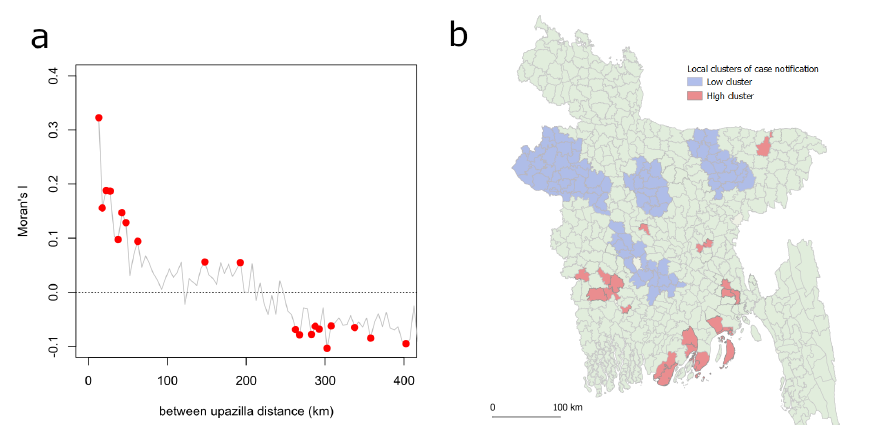
Figure 2. ( a ) Spatial correlogram showing the strength of the spatial autocorrelation that was observed between adjacent upazilas of incremental distances. Significant autocorrelations ( p < 0.01) at various distances are labeled with red dots. ( b ) Cluster map showing clusters of upazilas reporting high (red) and low (blue) case notification rates in 2016.